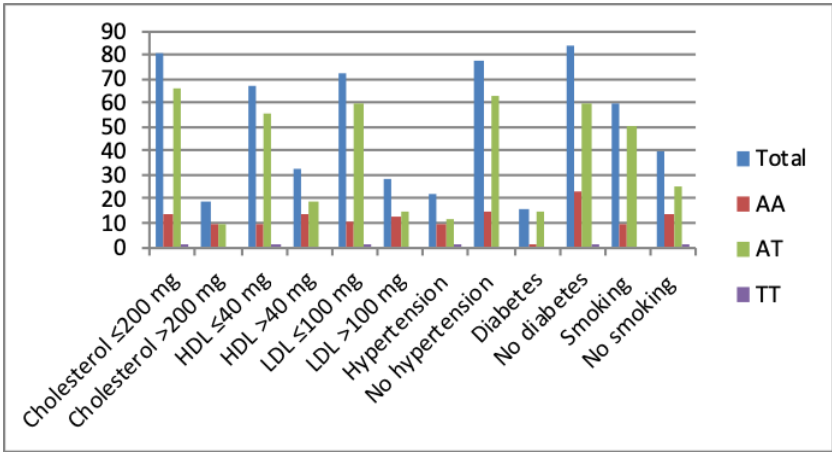
Figure 4. The rs2274907 A>T genotype distribution with an elevated or normal lipid profile, presence or absence of hypertension and diabetes, smoking or no smoking.